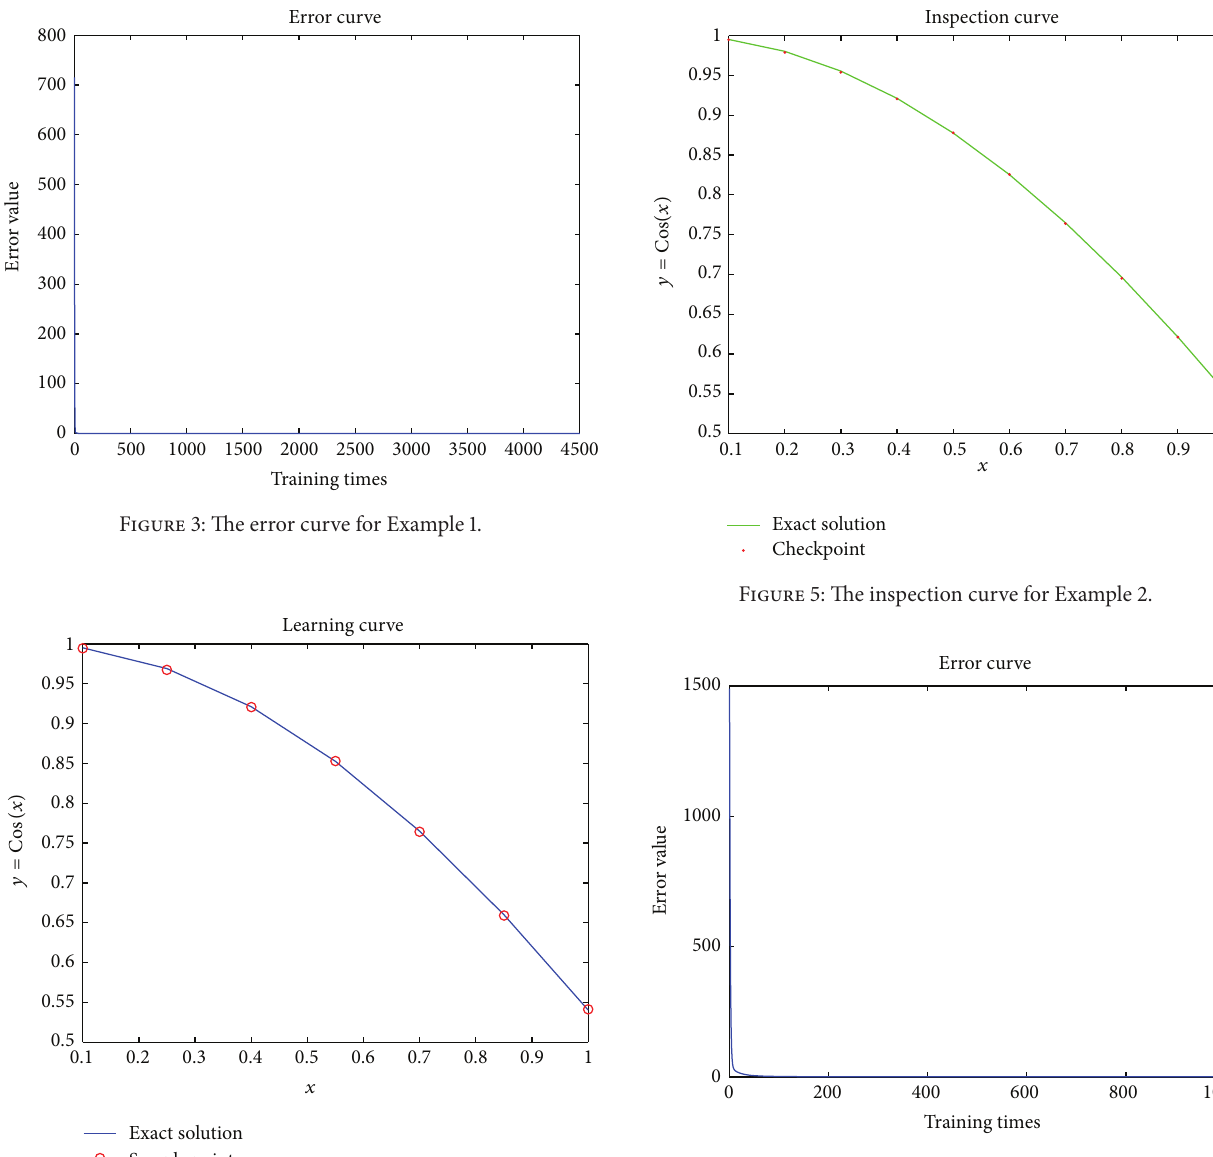
Figure 6: The error curve for Example